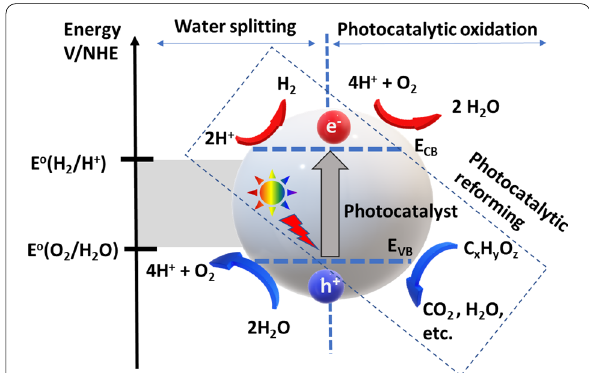
Fig. 1 Schematic illustration of water splitting and photocatalytic oxidation of biomass over photocatalyst nanoparticle under light illumination. (Adapted from Kondarides et al. and Huang et al. [9,